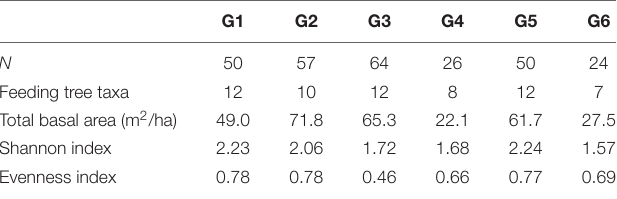
TABLE 3 | Number of trees, species, total basal area, and diversity indices of feeding trees registered in the home range of six groups (G1–G6) of black howler monkeys ( Alouatta pigra ) at Escárcega, State of Campeche, Mexico.